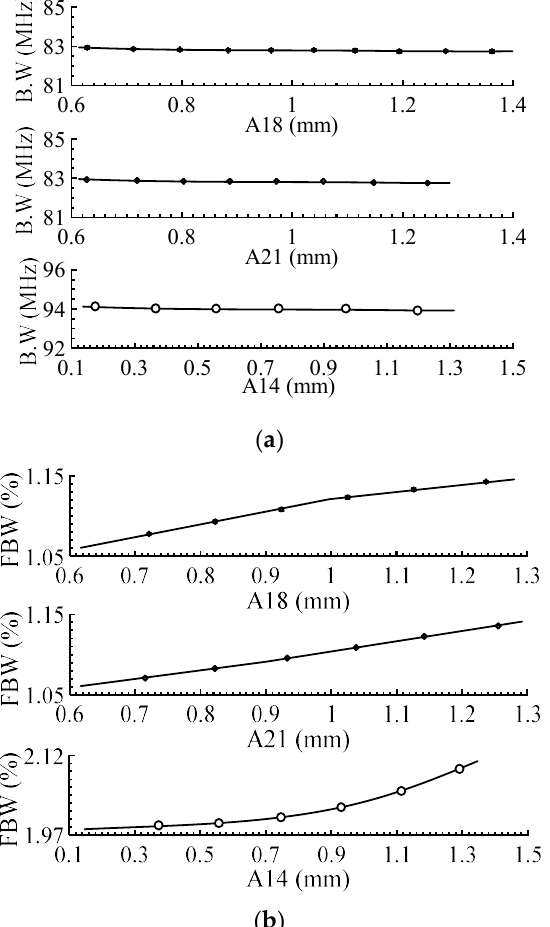
Figure 11. ( a ) Variations of bandwidth as a function of A 18 , A 21 and A 14 , ( b ) Variations of fractional bandwidth (FBW) as a function of A 18 , A 21 and A 14.